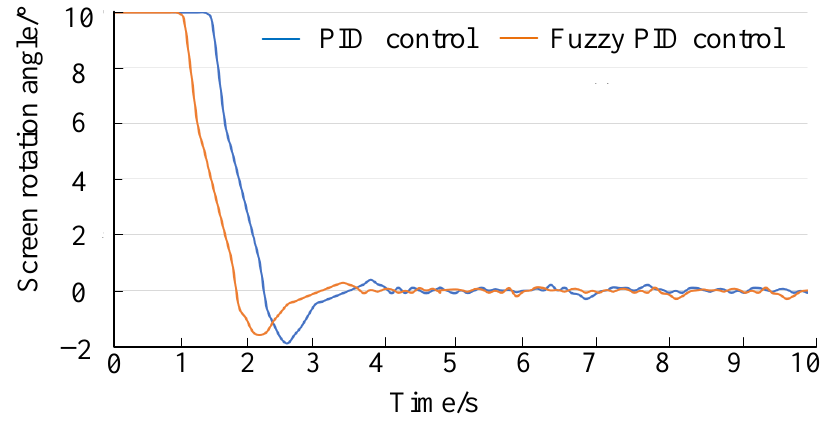
Figure 11. Comparison of PID and fuzzy PID.